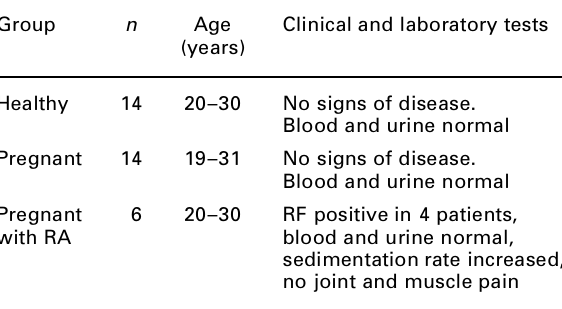
Table 1. Characteristics of the women investigated